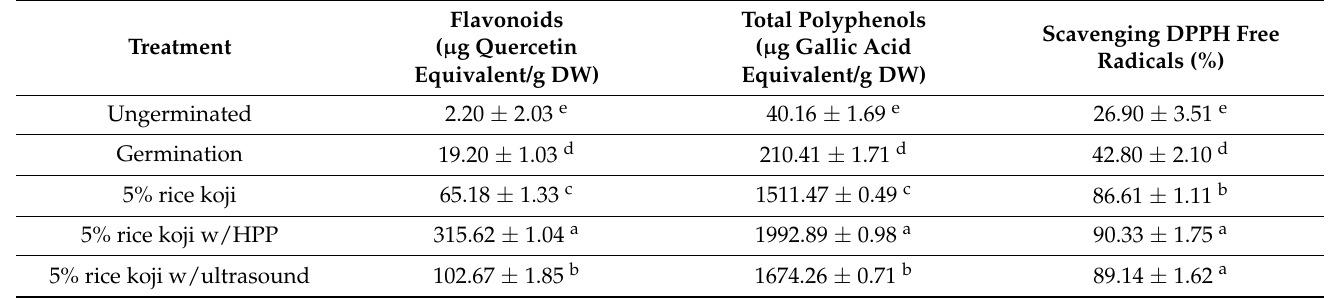
Table 7. Antioxidant components of germinated peanuts in with rice koji with HPP or ultrasonic